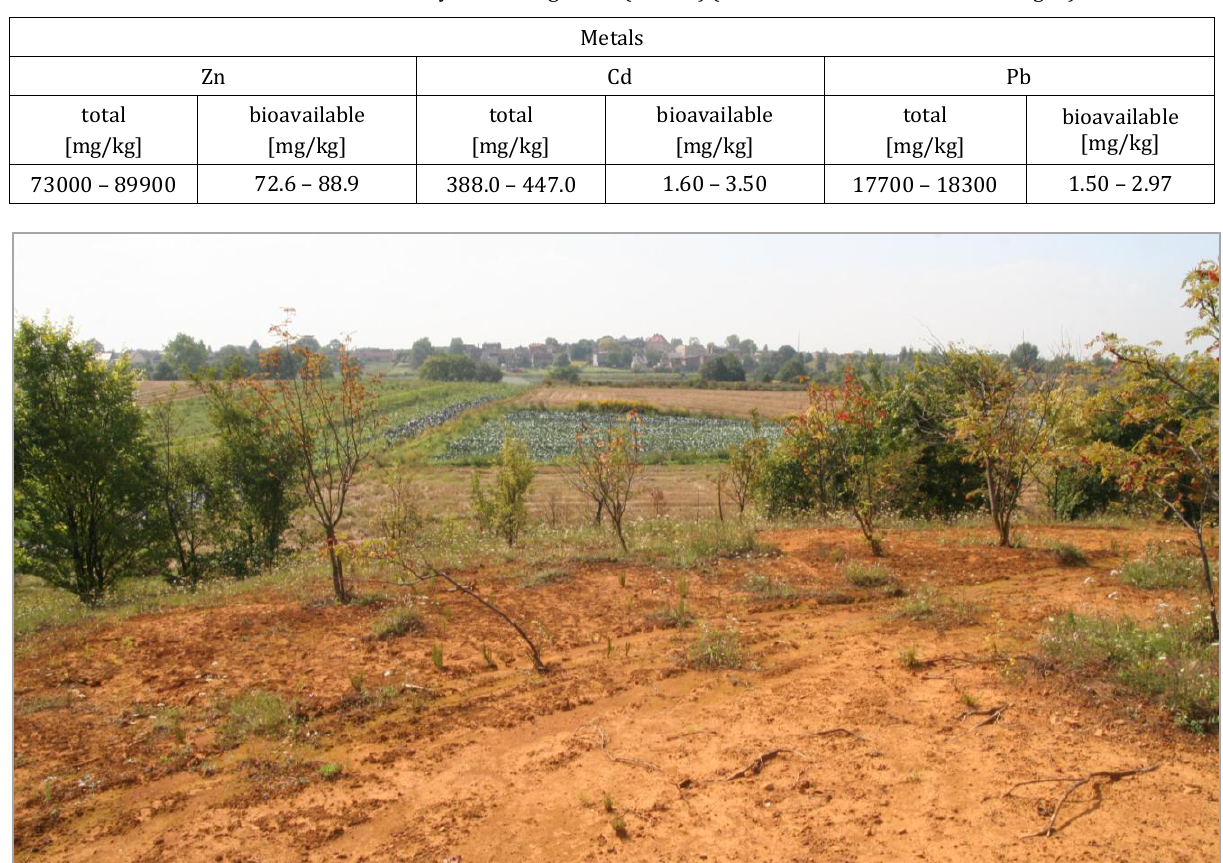
Table 2. Concentration of heavy metals of ground (wastes) (after Kucharski et al., 2010, changed)